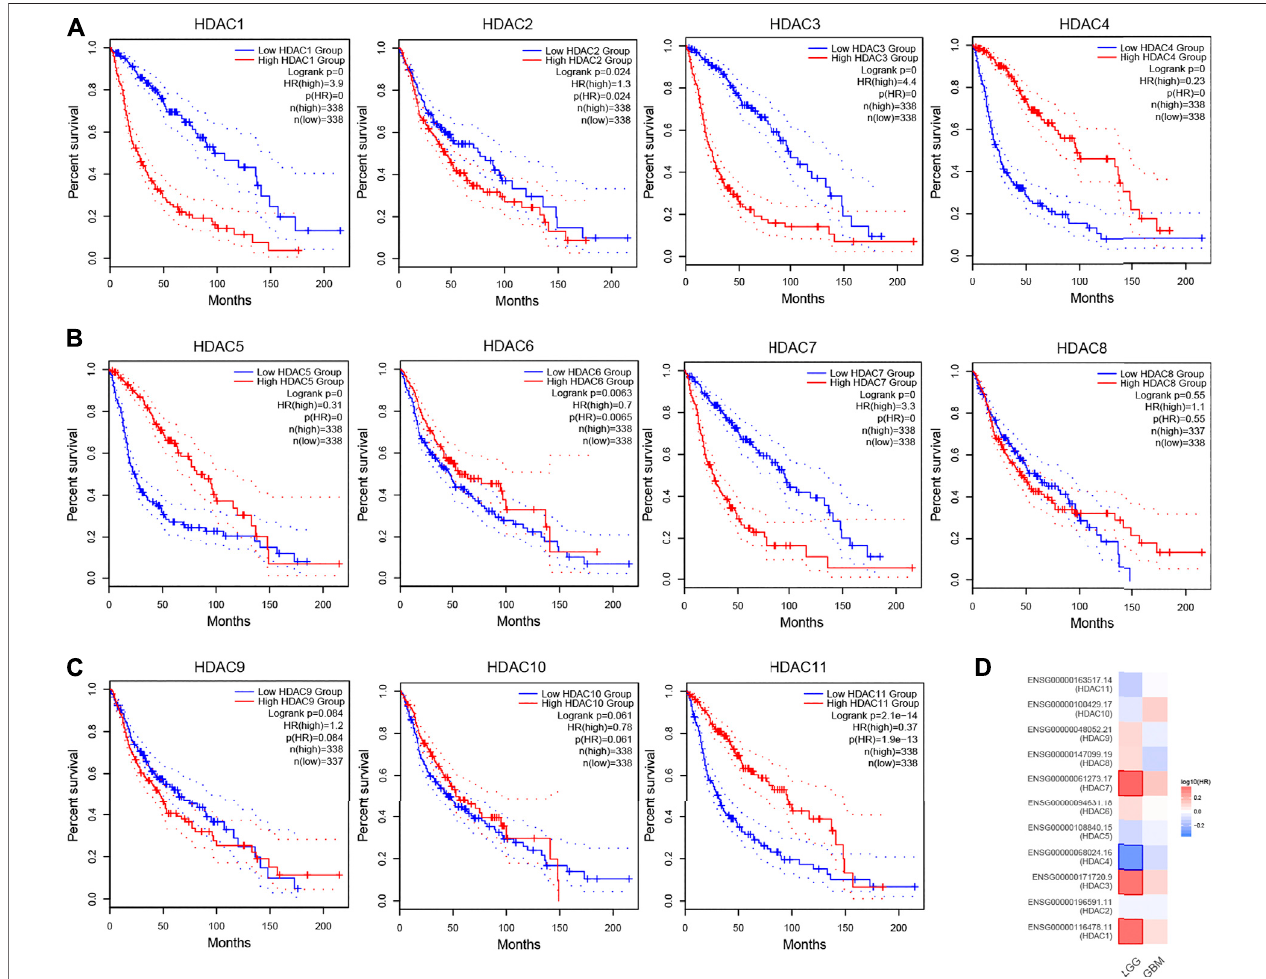
FIGURE 5 | Prognostic evaluation (OS) of HDAC family in glioma based on GEPIA. (A – C) The KM survival curves showed distinct survival possibility predicted by varying expression of HDAC family. (D) The heatmap was used for the link between the HDAC family members ’ expression and the OS of LGG and GBM patients.